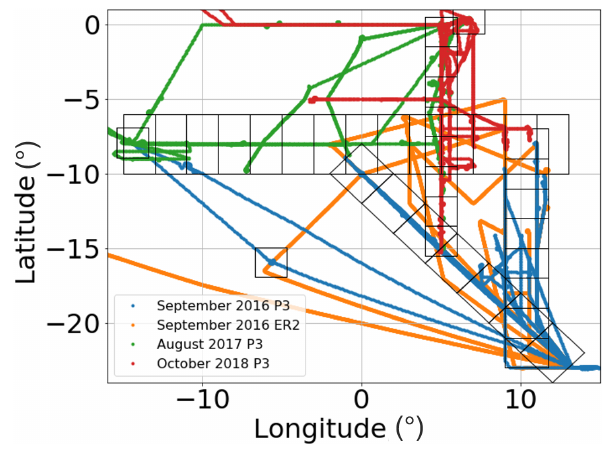
Figure 2. The flight paths of ORACLES. The boxes for mesoscale monthly-mean sampling are